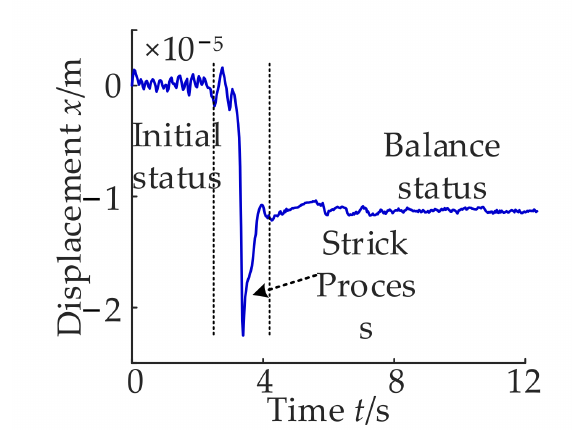
Figure 13. Displacement of rotor by test when K p = 30.